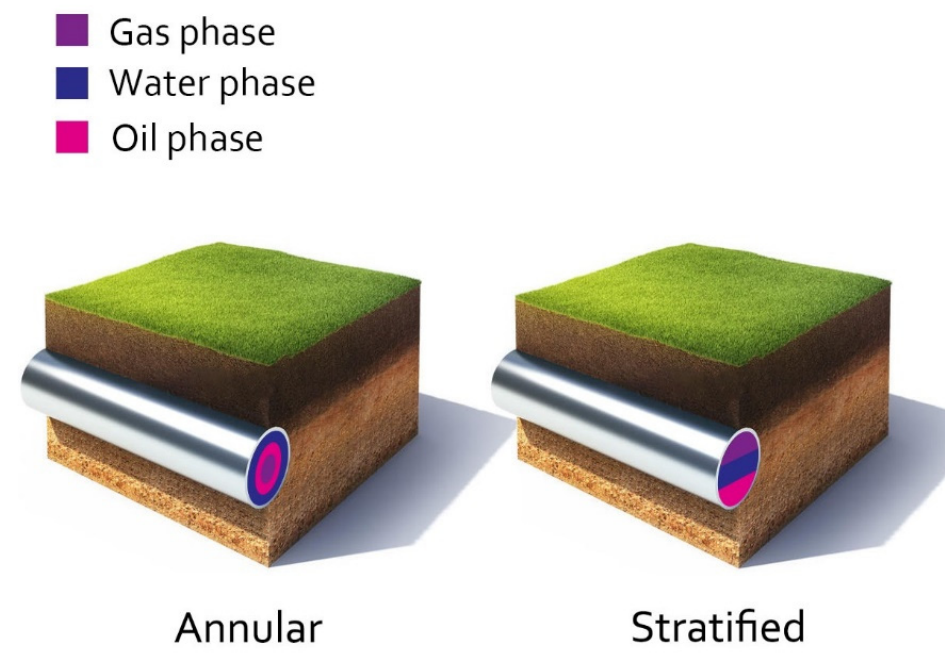
Figure 3. Simulated flow regimes.